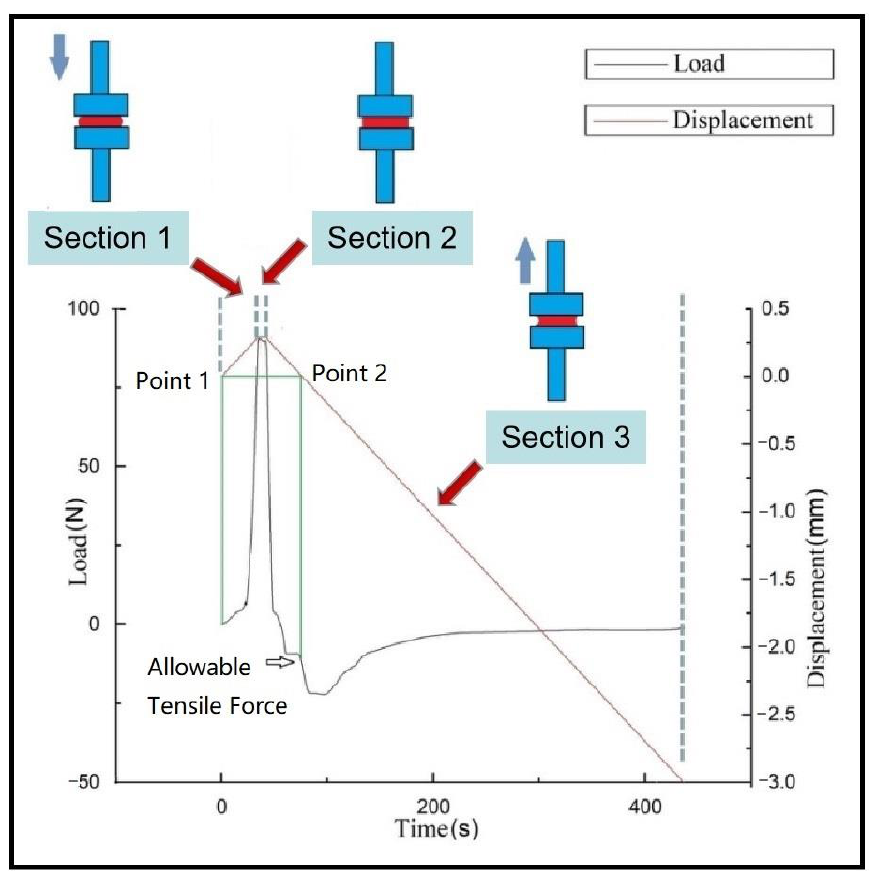
Figure 9. Example of probe test curve.